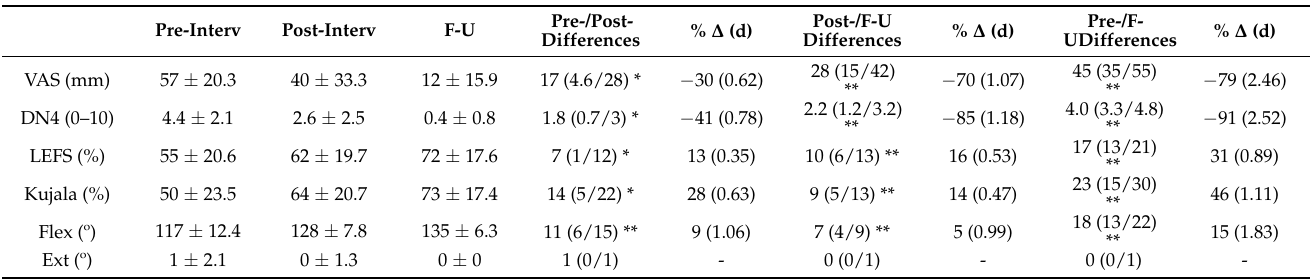
Table 2. Pre-intervention, post-intervention and follow-up mean score changes of knee pain and lower extremity function.